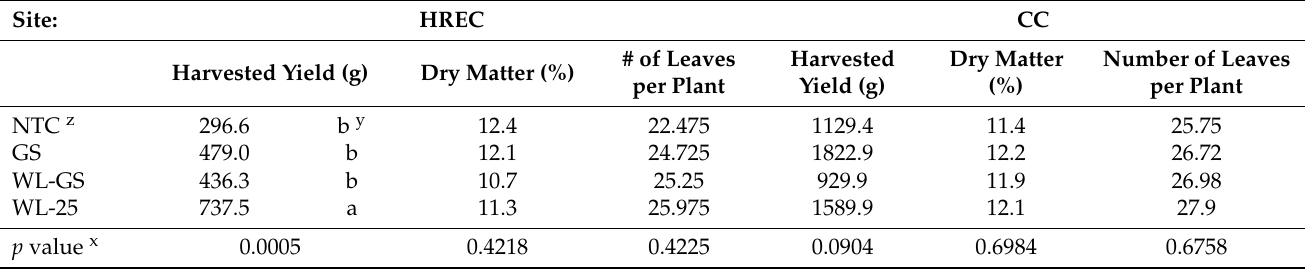
Table 4. Spinach harvest at two sites. Total harvested yield collected from 1 m 2 section of plant bed. Dry matter collected from difference in wet and dry weights of ten plants. Leaves per plant recorded from ten-plant subset of